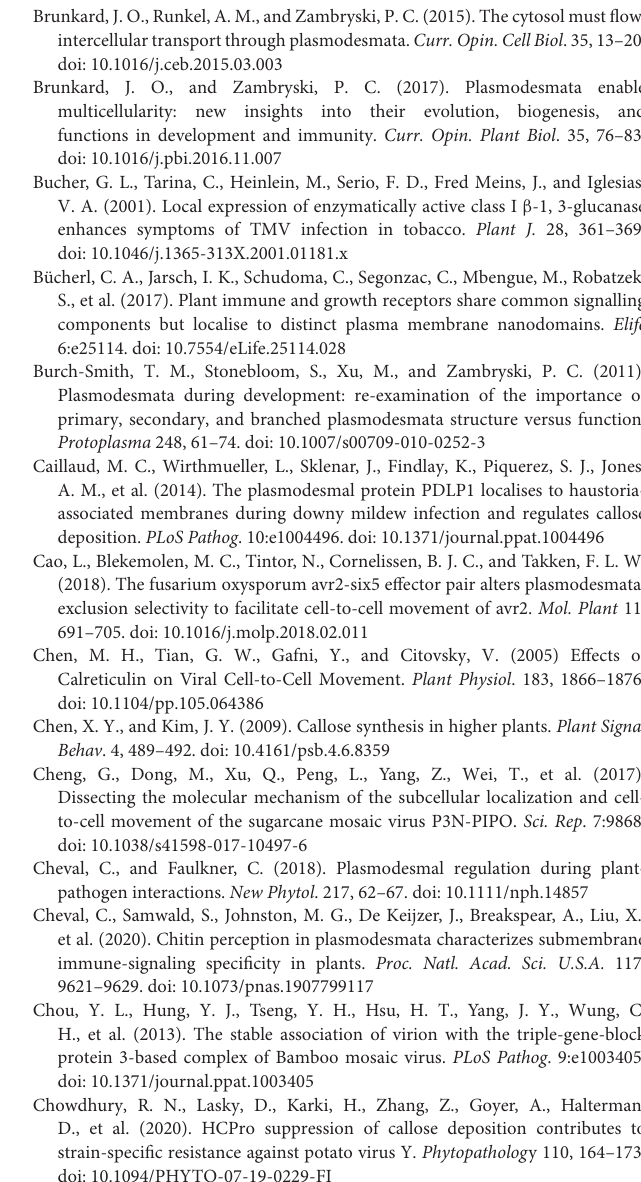
Supplementary Figure 1 | Sequence alignments of callose synthase proteins in A. thaliana . Protein sequences from AtCalS1 (NP_563743.2), AtCalS2 (Q9SL03.3), AtCalS3 (Q9LXT9.3), AtCalS4 (Q9LTG5.2), AtCalS5 (Q3B724.1), AtCalS6 (Q9LYS6.2), AtCalS7 (NP_172136.2), AtCalS8 (Q9LUD7.2), AtCalS9 (Q9SFU6.2), AtCalS10 (ACV04899.1), AtCalS11 (Q9S9U0.1), and AtCalS12 (Q9ZT82.1). The red boxes and asterisks denote those amino acids mutated in cals3m which are conserved in CalS1 and